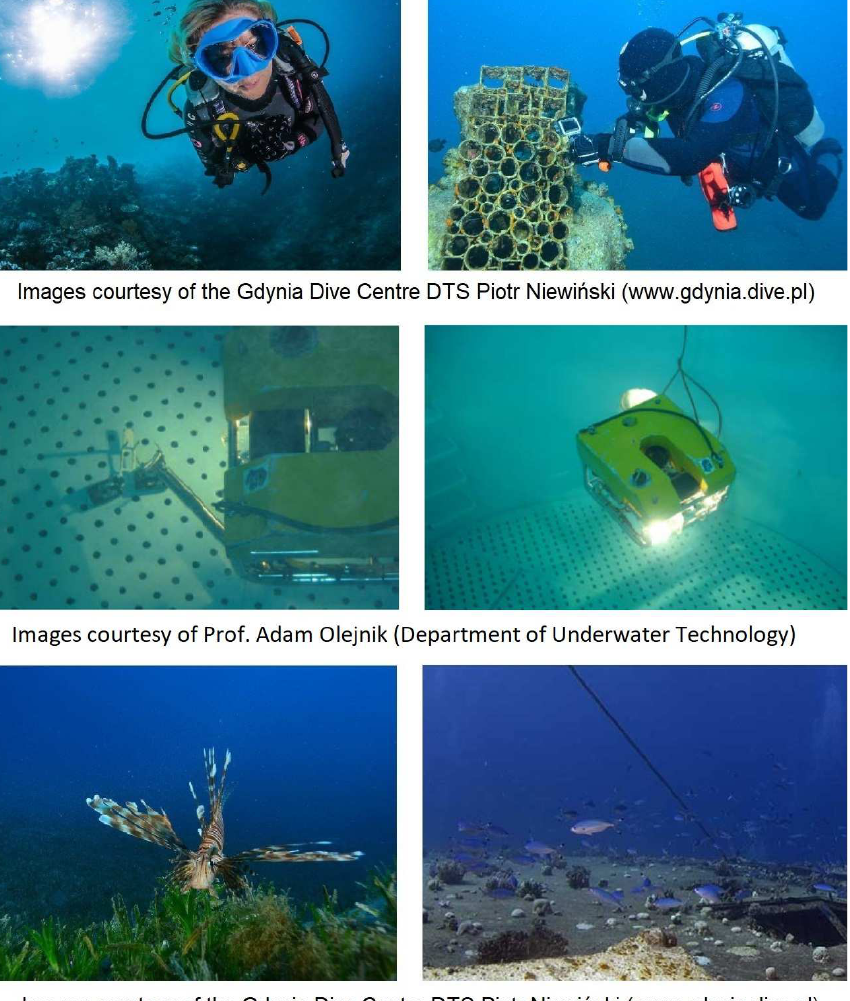
Figure 5. Images from the dataset: divers (first row), UUVs (second row) and fishes (third